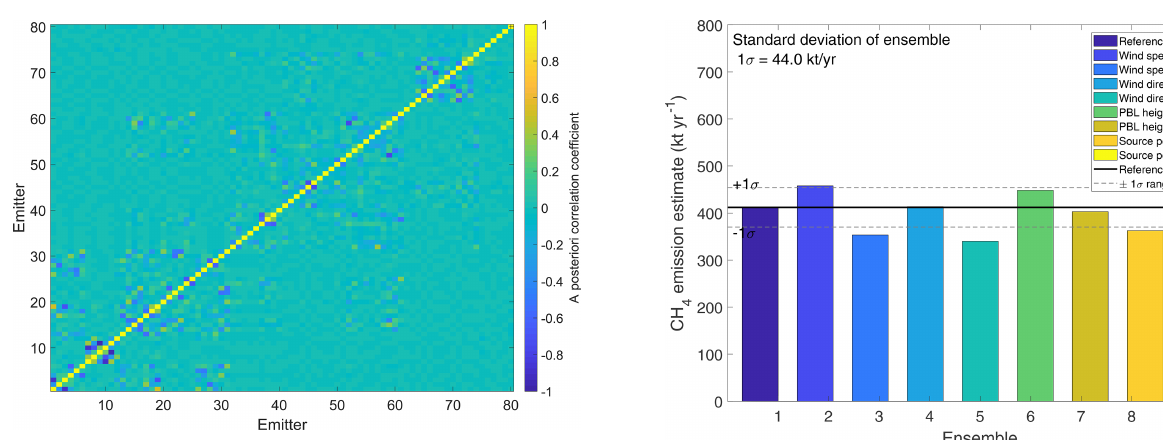
Figure 13. Ensemble runs to assess uncertainty in the flux estimates derived using a model-based approach. All selected error sources contribute to total uncertainty on a similar